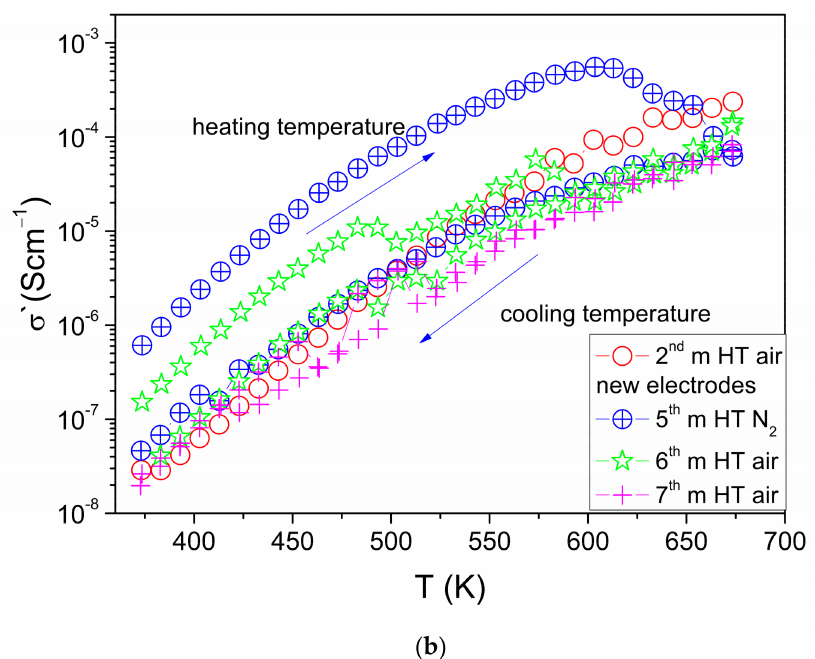
Figure 2. The temperature dependence of the real part of the AC conductivity at a frequency of 100 Hz for ( a ) 1st, 2nd, 3rd, 4th, and 5th tests and ( b ) 2nd, 5th, 6th, and 7th